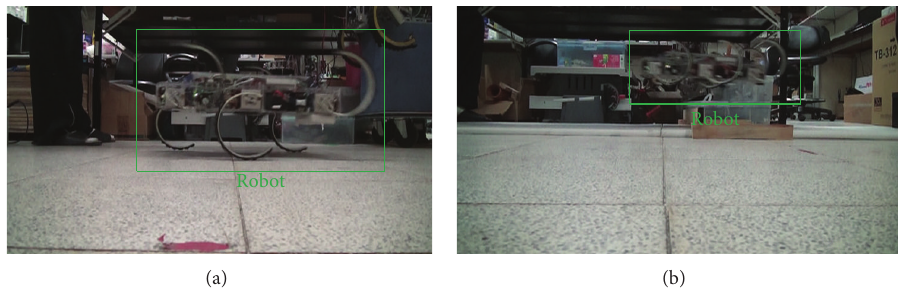
Figure 13: The robot installed with the fiberglass composite legs performs walking (a) and leaping (b) behaviors.